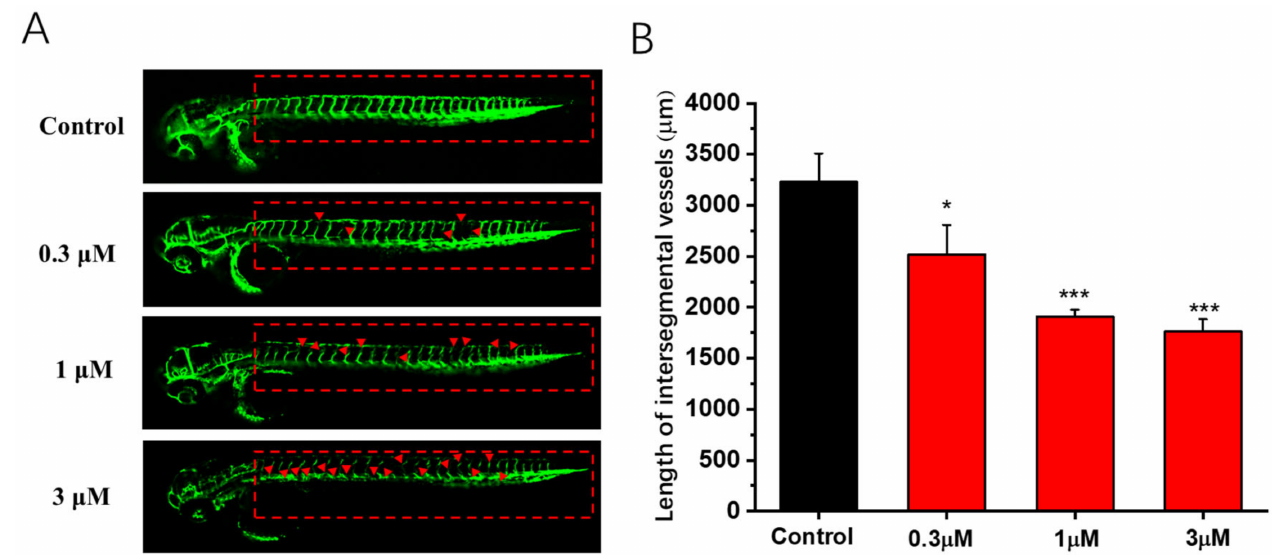
Figure 7. Antiangiogenesis activity of compound 1b in the transgenic zebrafish model. ( A ) Represen- tative images of zebrafish embryos from transgenic zebrafish Tg ( fli1:EGFP ) treated with the vehicle and different concentrations of compound 1b (0.3, 1, and 3 µ M) at 48 hpf. The absence and breakage of ISVs are indicated by red arrows. ( B ) Average total lengths of the ISVs of zebrafish after treatment with various concentrations of compound 1b . Results are presented as the means ± SD ( n = 3). * p < 0.05, *** p < 0.001 vs. the control